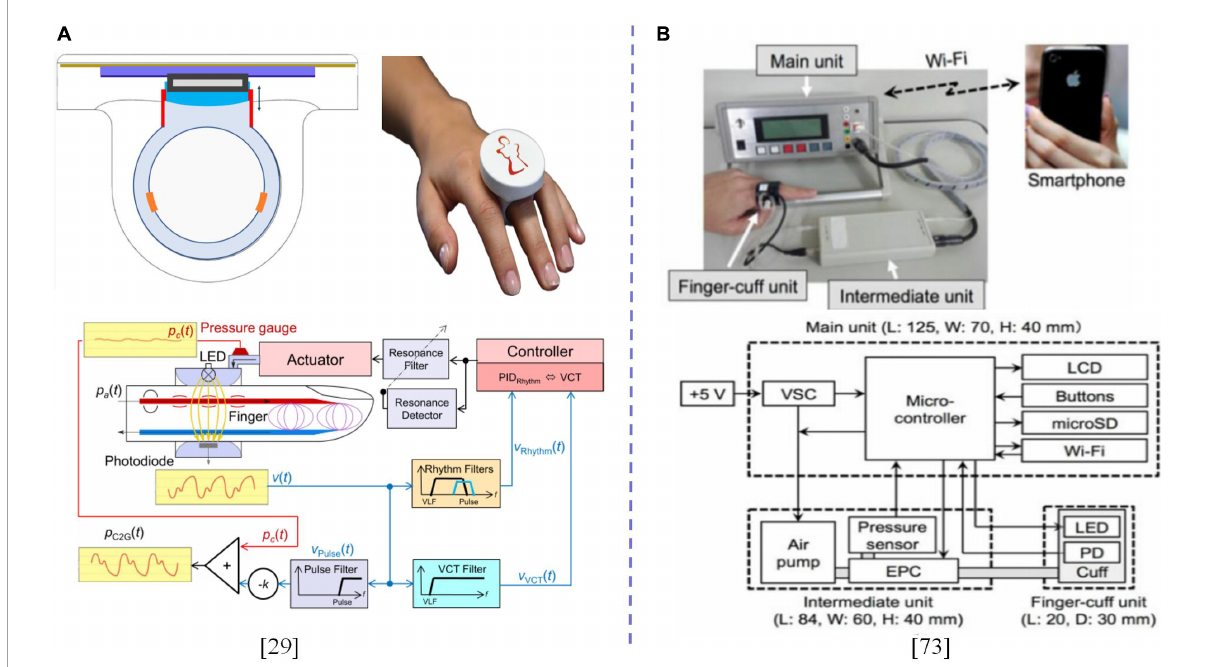
FIGURE4 (A) Design of the CNAP2GO finger-ring with proposed block diagram and signal flow. (B) Image and block diagram of the prototype standalone instantaneous BP monitoring system. The dotted line is used to distinguish between different